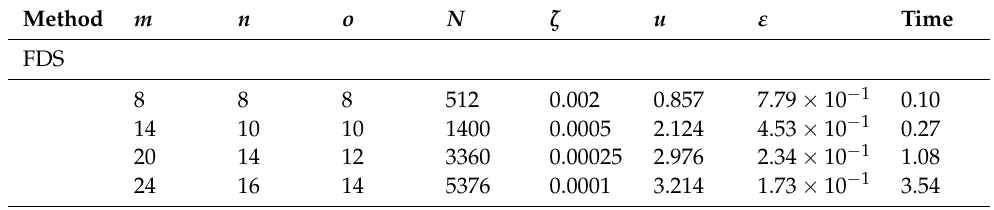
Table 4. Computational results and comparisons for Case